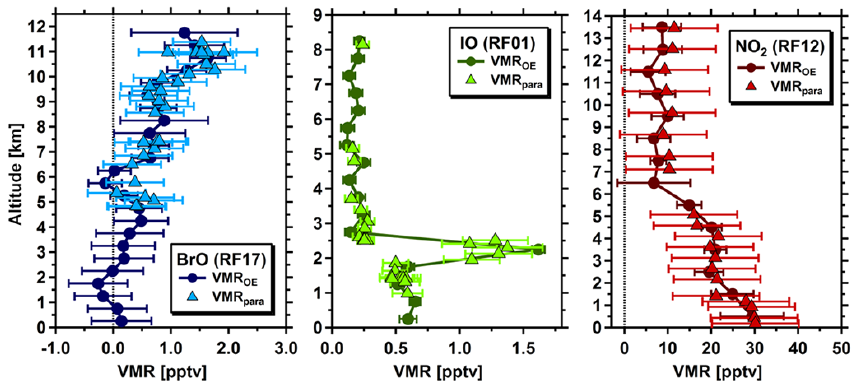
Figure 7. Comparison of VMR data retrieved from TORERO AMAX-DOAS data using the parameterization retrieval (para) or optimal estimation (OE) for select BrO (left), IO (middle) and NO 2 (right)